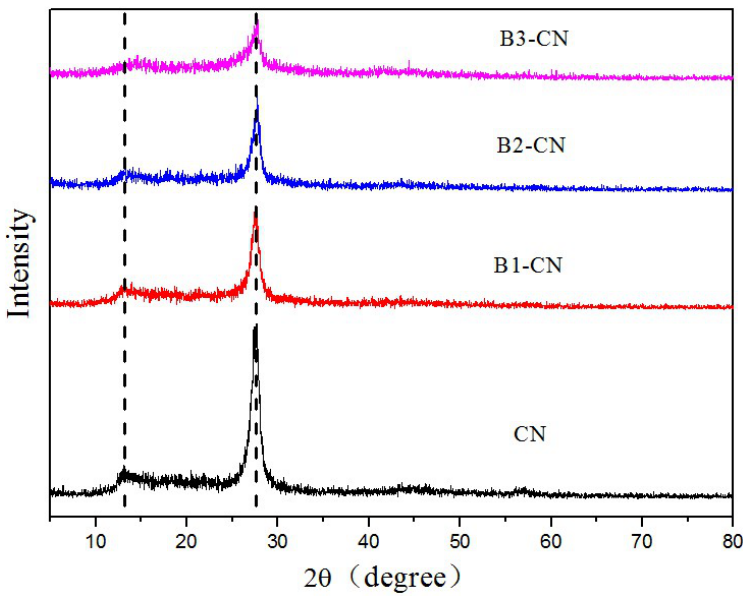
Figure 2. XRD patterns of pure CN and B 2 O 3 /CN composite materials with different CN/B 2 O 3 proportions (CN/B 2 O 3 = 3:1 (B1-CN), 1:1 (B2-CN), 1:3 (B3-CN)).